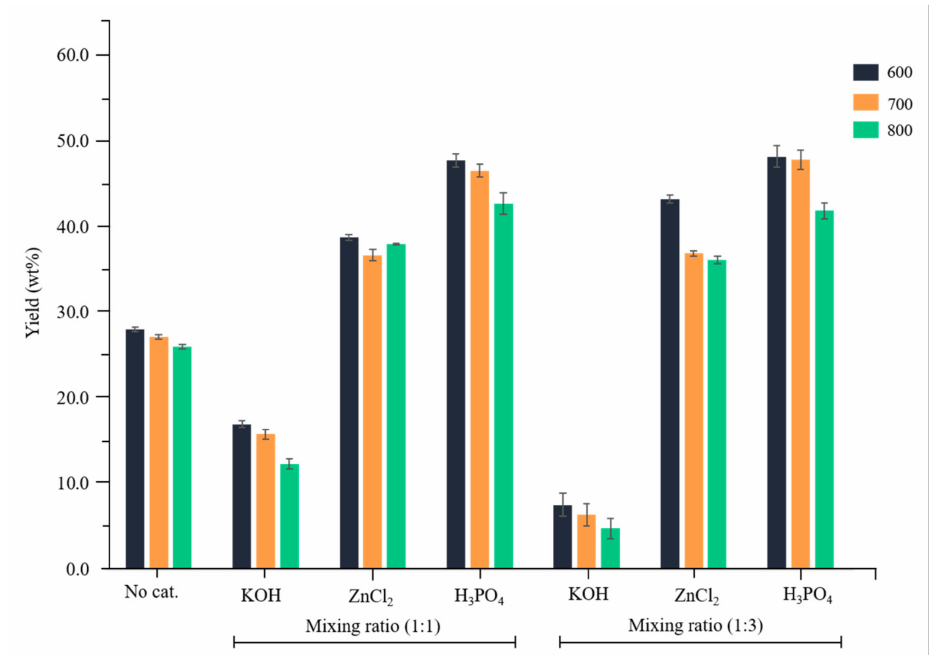
Figure 2. Comparison of yields of empty fruit bunch activated carbon (EFBAC) prepared by different temperatures, activating agents and mixing ratio of activating agent of 1:1 and 1:3, w / w